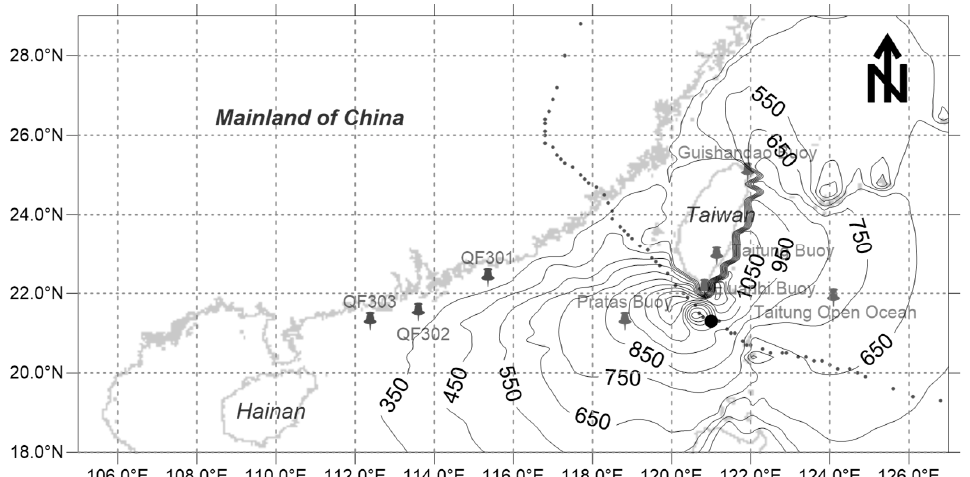
Figure 7. A wave field (unit: cm) induced by the wind field from the standard H10 (B2-A1-A1) at Eluanbi Station peak wave time during Typhoon Meranti (142016), where the bigger black dot is the location of the typhoon’s center.